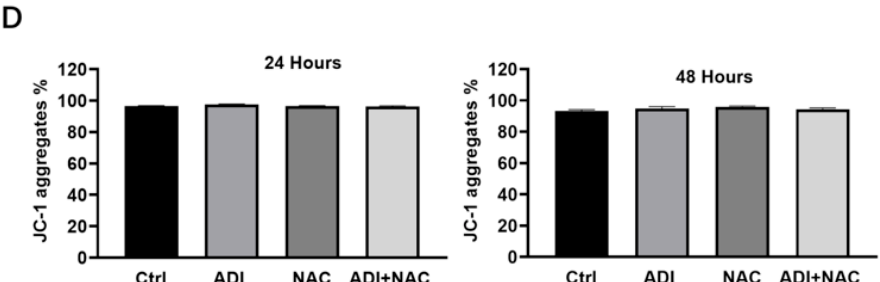
Figure 4. Effects of ADI and NAC on mitochondrial membrane potential. ( A ) Effects of ADI-PEG 20 and NAC at different time courses (24, 48 h) in MC38 cell mitochondrial membrane potential. ( B ) Bar graph representing the percentages of JC-1 aggregates of the JC-1-stained MC38 cells. ( C ) Effects of ADI-PEG 20 and NAC at different time courses (24, 48 h) in MDA-MB-231 cell mitochondrial membrane potential. ( D ) Bar graph representing the percentages of JC-1 aggregates of the JC-1-stained MDA-MB-231 cells. Mean values ± SD of three separate experiments performed in triplicate. ** p < 0.01 (comparison to the control).